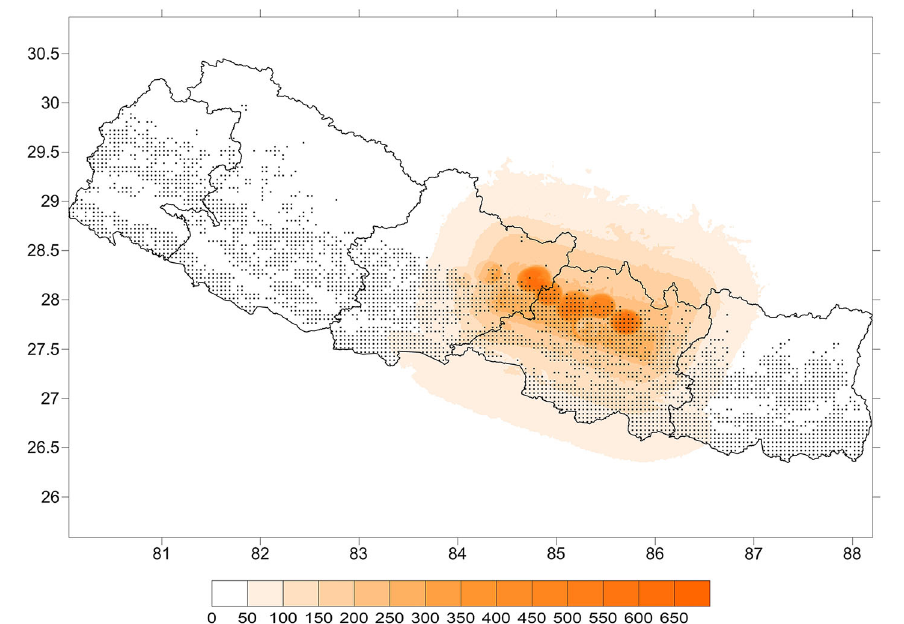
Fig. 3 PGA (gal) for the Gorkha April 2015 earthquake in